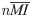
Correlation between the values of nMI¯ before and after intra-architectural domain sequence shuffling.Number of domain pairs (data points) N = 5, 205. The value of the Pearson correlation coefficient r ≈ 0.345; the value of the Spearman’s rank correlation coefficient ρ ≈ 0.432.